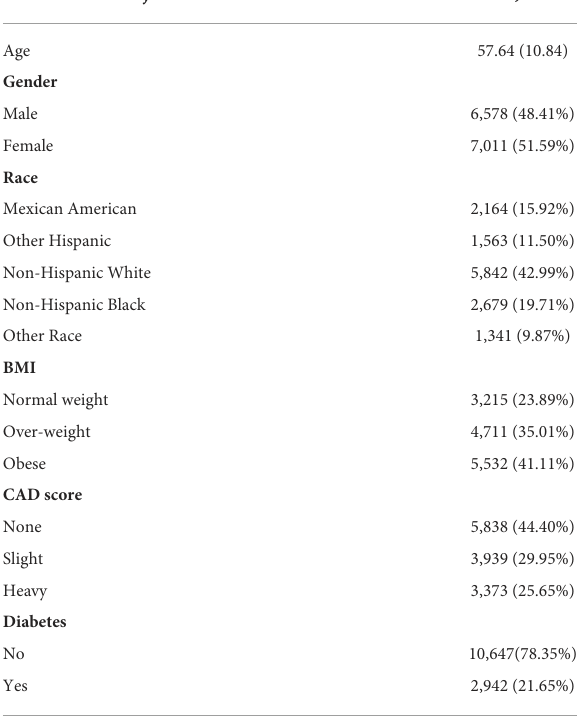
TABLE 1 Baseline characteristics of participants a